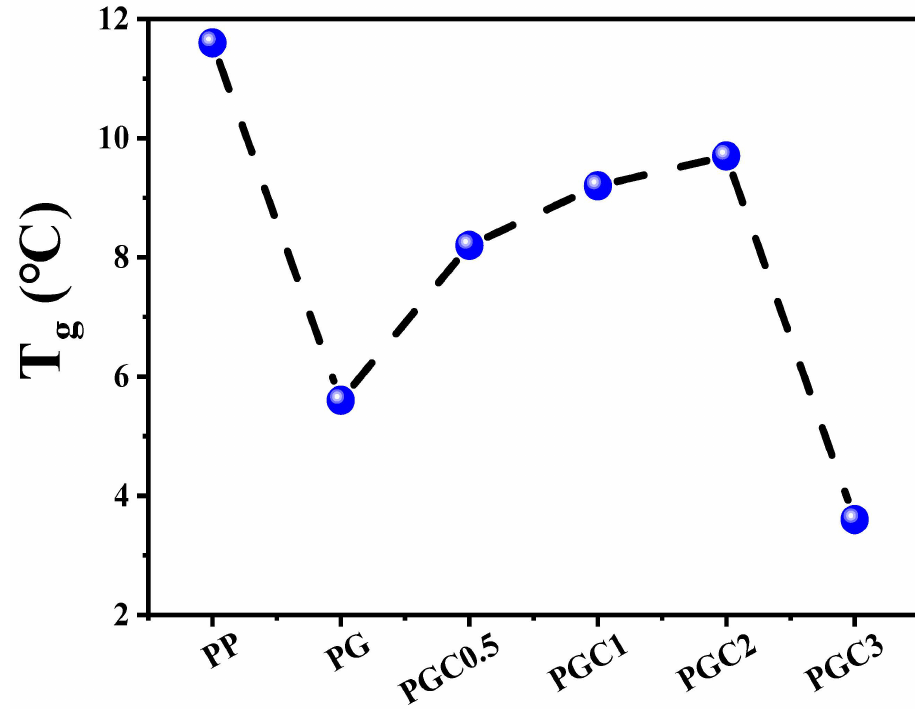
Figure 6. T g of PP and the PP/DCP/GMA/C blends with different tea polyphenols (C) loading measured from DMA.